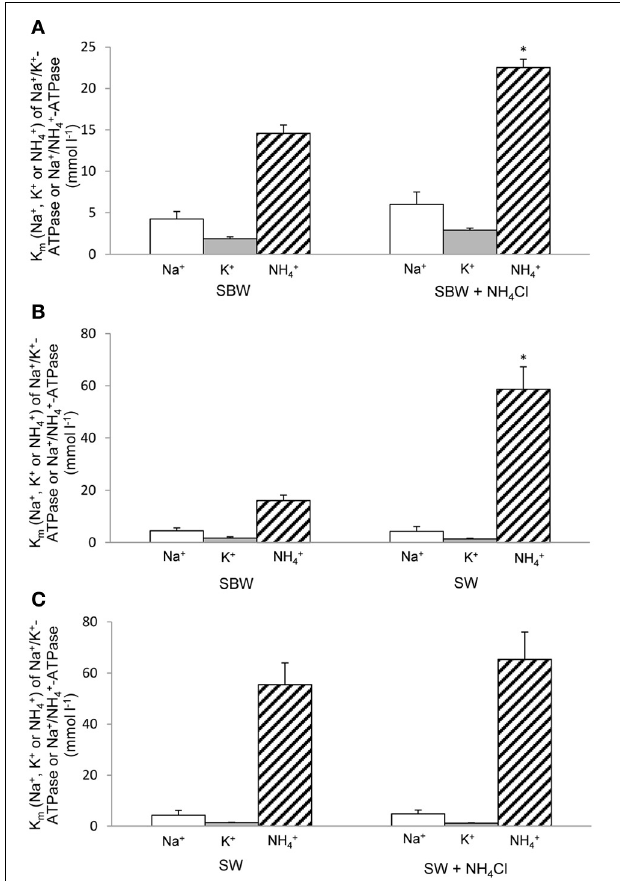
FIGURE 3 | Specific activity of Na + /K + (NH + 4 )-ATPase under various experimental conditions. Effects of 6-days exposure to (A) slightly brackish water (SBW; salinity 3) containing 75mmol l − 1 NH 4 Cl, (B) seawater (SW; salinity 30), or (C) SW containing 50mmol l − 1 NH 4 Cl on the specific activity ( μ mol P i min − 1 mg − 1 protein) of Na + /K + (NH + 4 )-ATPase from gills of Periophthalmodon schlosseri which had been kept in SBW for 2 weeks. Results represent mean ± s.e.m. ( N = 4). ∗ Significant difference from the corresponding control ( P < 0 .